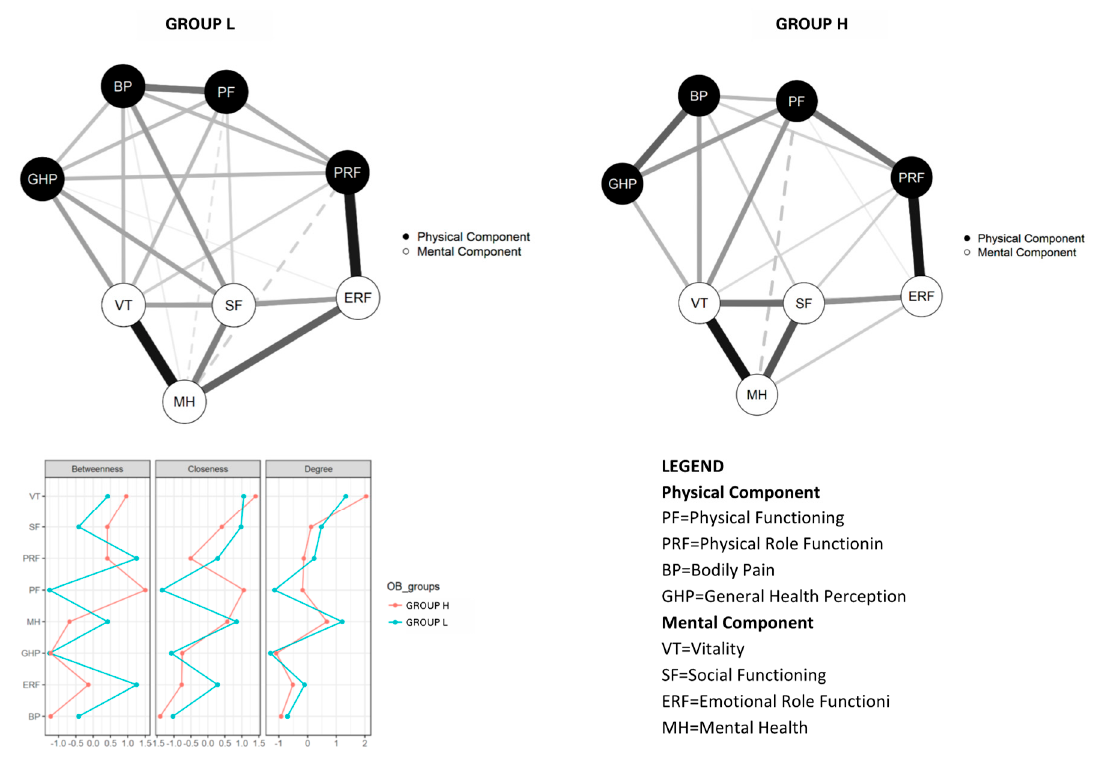
Figure 1. The network of SF-36 quality-of-life domains for patients with obesity walking less than predicted during the six-minute walking test (Group L, on the left), and for patients with obesity walking as far as or farther than predicted during the six-minute walking test (Group H, on the right), and their respective centrality indices (panel C: red line = Group L; blue line = Group H).